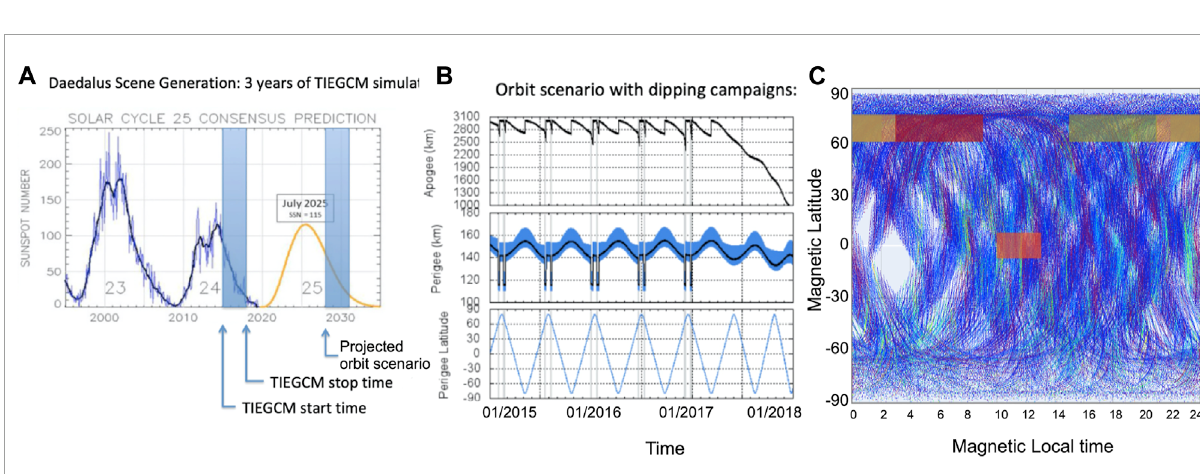
FIGURE 7 (A) : Historical record of solar cycles 23 and 24, and consensus prediction of solar cycle 25. (B) : Orbital parameters based on simulations of a sample Daedalus orbital scheme. (C) : Latitude vs local time coverage in the 100–200 km altitude range; color-coded is the Kp index, ranging from 0 (in blue) to 9 (in